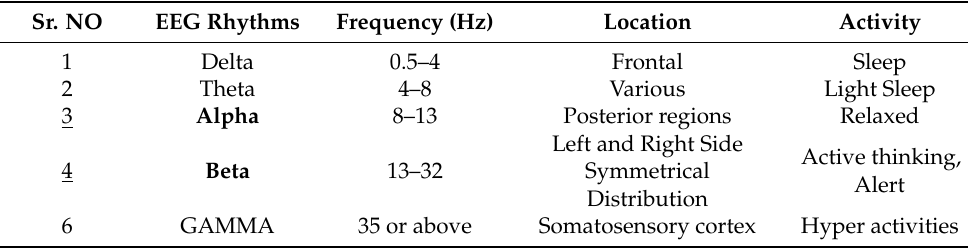
Table 2. EEG Waves